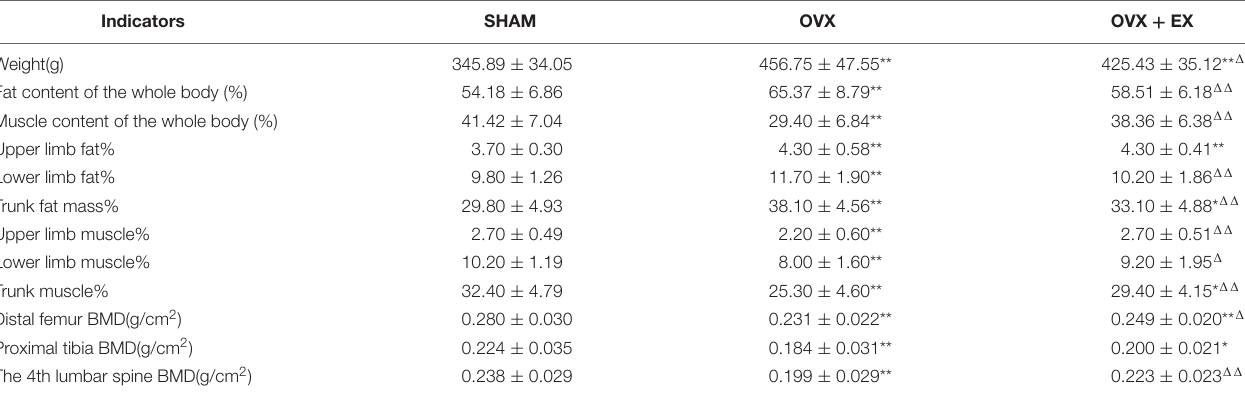
TABLE 2 | Comparison of body weight, body composition and bone mineral density of rats in each group. Indicators SHAM OVX OVX +